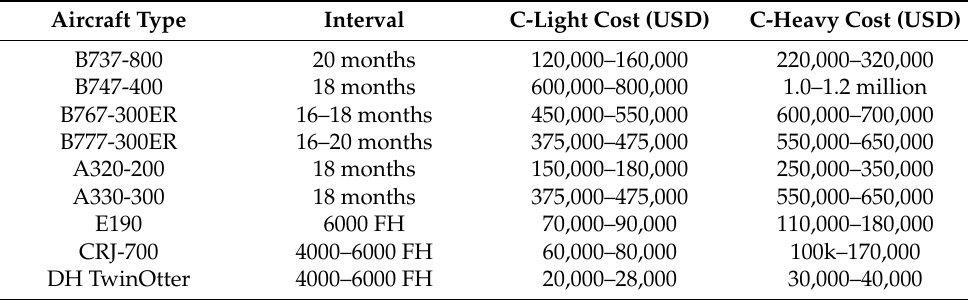
Table 10. Approximate costs for C-check inspection for a variety of aircraft categories [159].